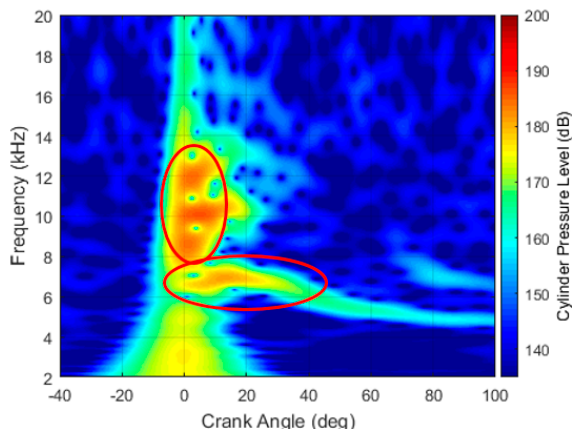
Figure 3. Time-frequency distribution (TFD) of the high-frequency in-cylinder pressure oscillation under 1400 r / min full load condition.